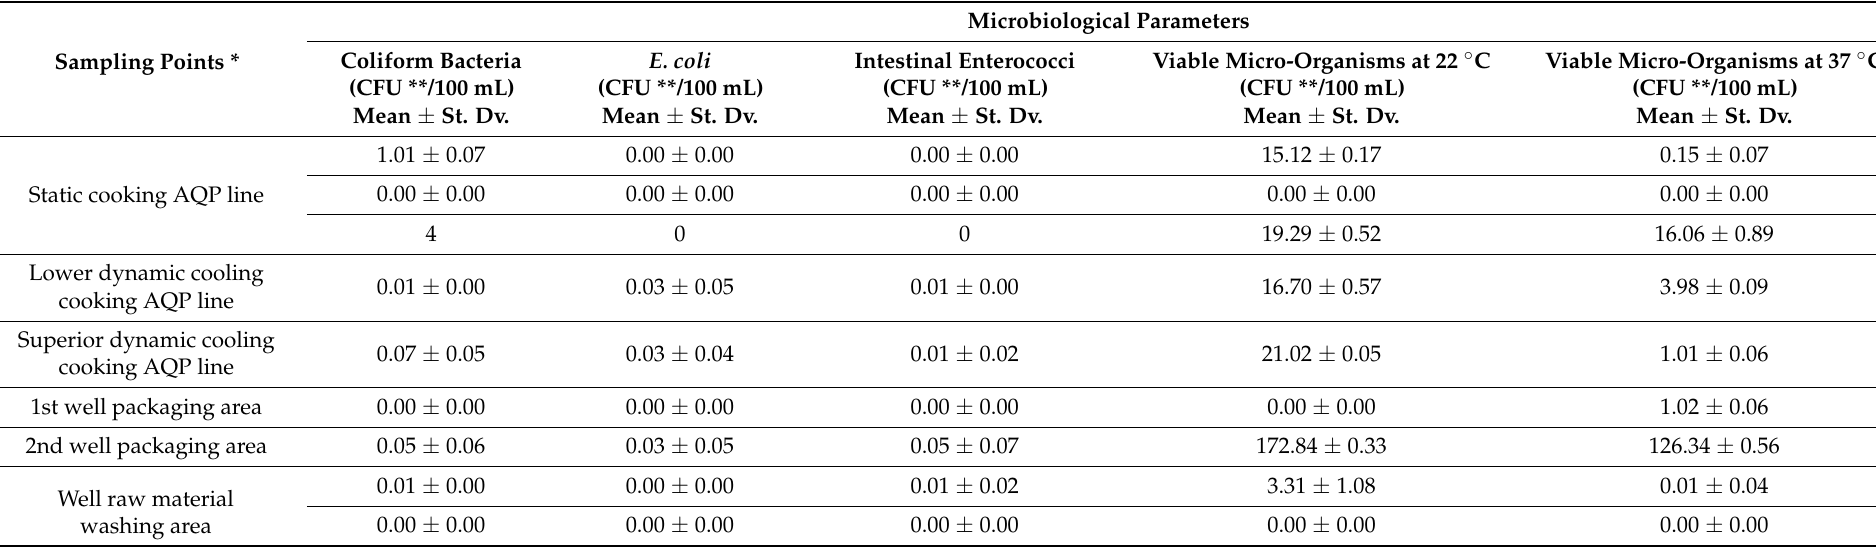
Table 7. Results of the average calculation for each microbiological parameter on the 48 water samples * from the sampling point monitoring in Case Study 3. Limits and methods of analysis specified by Lgs.D. 31/01 [18] on the quality of water intended for human consumption. * The samples were collected in two seasonal sampling campaigns carried out in April and October on all points of the monitoring network. ** CFU: colony-forming